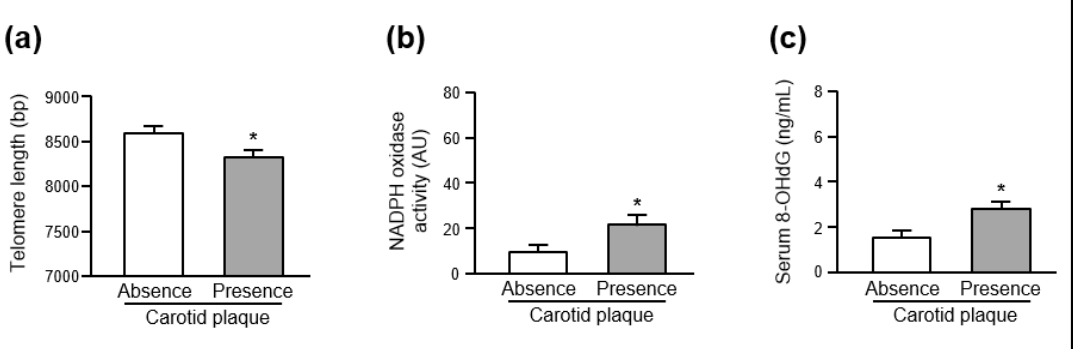
Figure 1. ( a ) Telomere length in circulating leucocytes, ( b ) NADPH oxidase-dependent superoxide production in peripheral blood mononuclear cells, and ( c ) serum 8-OHdG levels in asymptomatic individuals, according to the absence ( n = 389) or presence ( n = 116) of atherosclerotic plaques in carotid arteries. * p < 0.05 after adjusting for age and sex. bp, base pairs; AU, arbitrary units; 8OHdG, 8-hydroxy-2-deoxyguanosine.